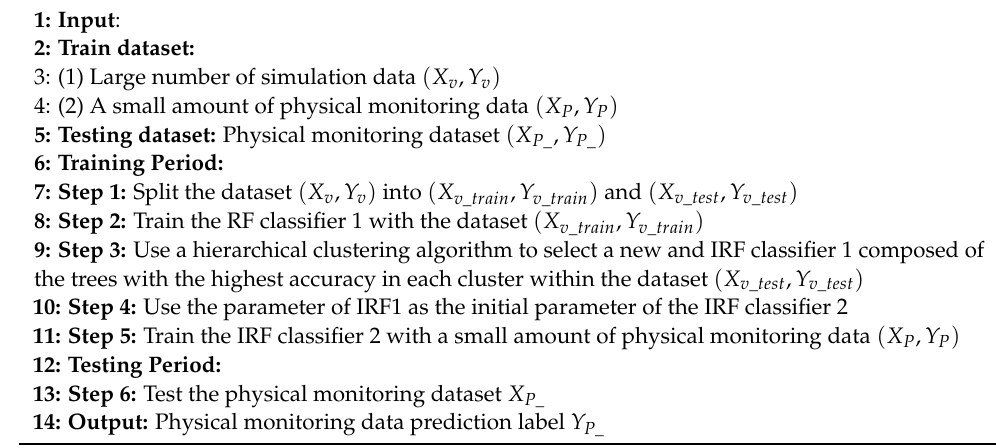
Algorithm 1 Pseudocode of the Proposed